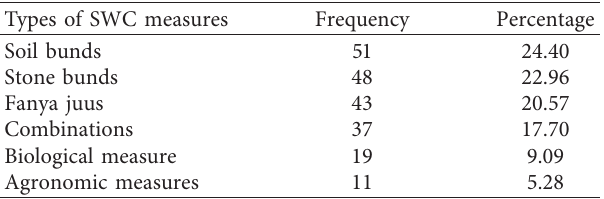
Figure 2: Some of the implemented physical SWC measures of Damota area districts. Table 2: Major SWC measures implemented in the study area.